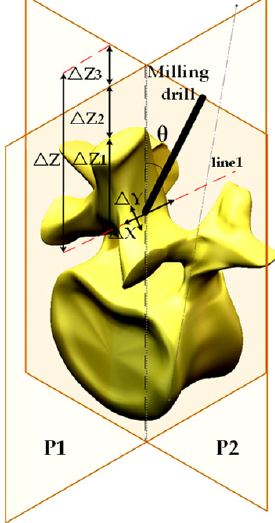
Figure 1. Anatomic size of human vertebra segment.